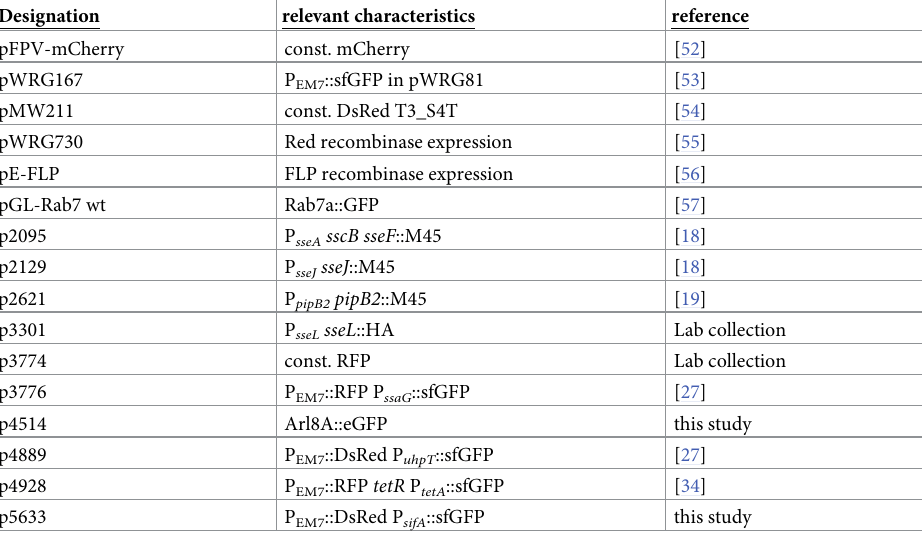
Table 2. Plasmids used in this